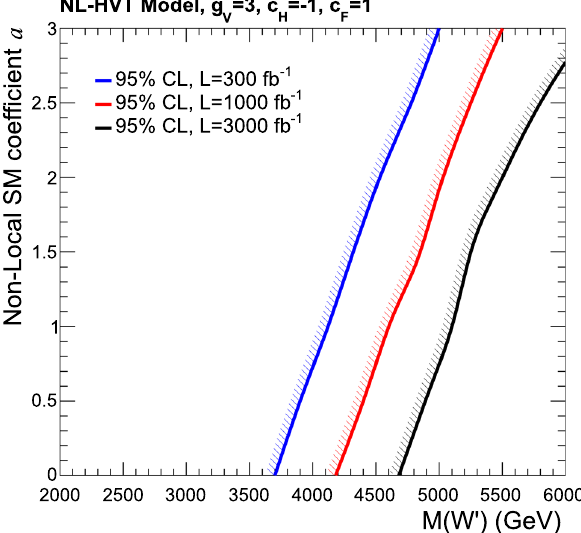
Fig. 9 95% Confidence Level limits in non-locality scale Λ NL as a function of the parameter a and the integrated luminosity, based on measurements of anomalous Higgs production from a W (cid:2)